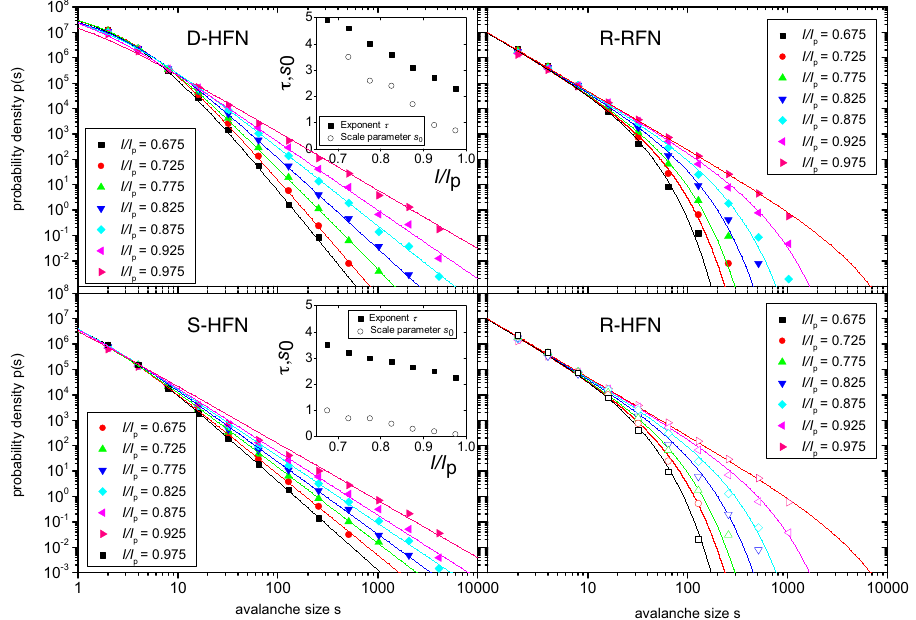
Figure 4. Avalanche statistics. Avalanche size distributions for HFN and random reference networks of size L = 512; top left: D-HFN, bottom left: S-HFN, the lines represent fits of Pareto distributions as given by Eq. (2), the fit parameters are shown in the insets; top right: R-RFN, bottom right: R-HFN, the lines represent a common fit to all data (R-RFN and R-HFN) using Eq. (1); all distributions are averaged over 3 × 10 5 realizations of the respective